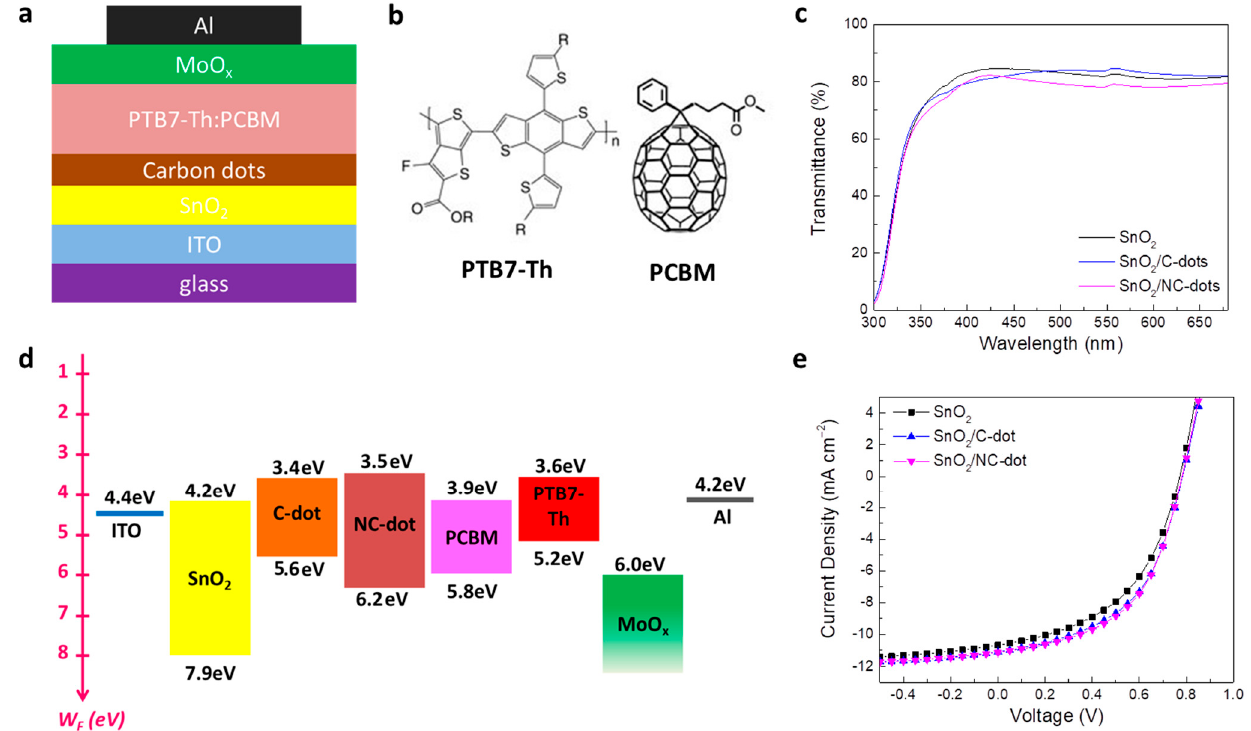
Figure 8. ( a ) Schematic representation of the fabricated inverted OSCs. ( b ) Chemical structure of the donor and acceptor materials used in the photoactive blended layer. ( c ) Transmittance spectra of the SnO 2 film coated with or without the C-dots and NC-dots. ( d ) Energy level diagram of the different layers used for the fabrication of the inverted OSCs. ( e ) Current density–voltage (J-V) characteristic curves measured under AM 1.5G illumination.